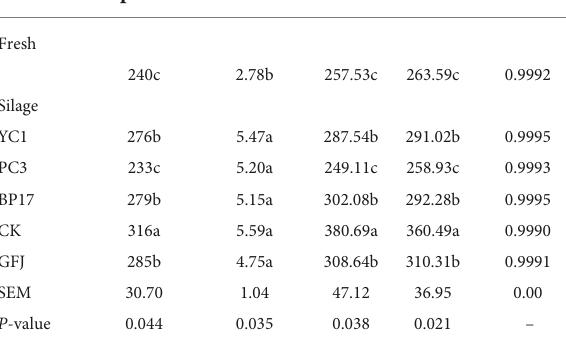
TABLE 6 The alpha-diversity of fungal community of fresh and ensiled paper mulberry. Samples Observed